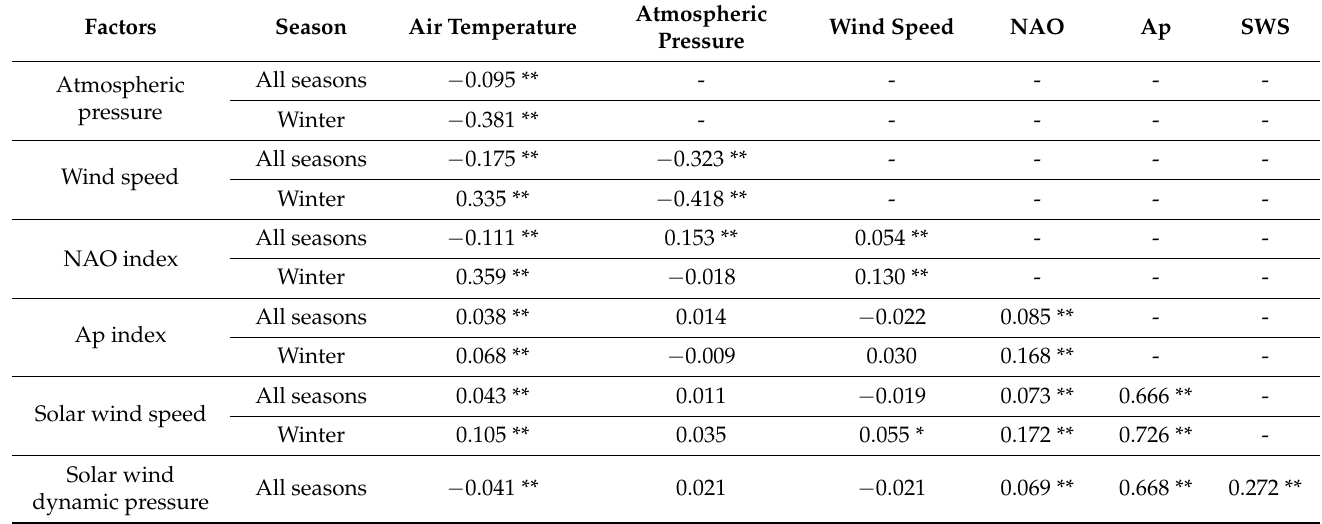
Table 4. Correlations between weather and space weather variables during all the study period and in